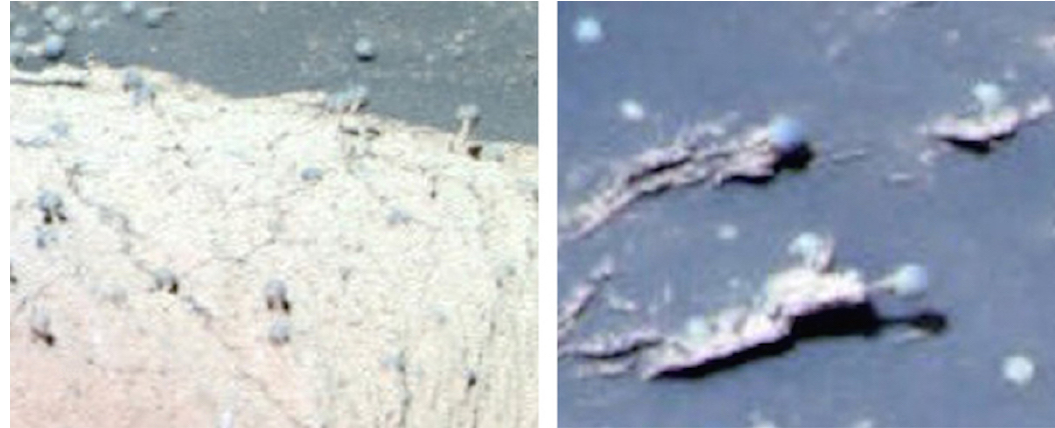
Figure 13. Mars. Sol 88 and Sol 37: Specimens resembling the mushroom-shaped lichen Dibaeis baeomyces Photographed in Eage Crater. (Reproduced with permission from Joseph et al.